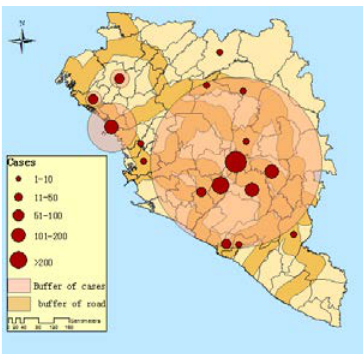
Figure 5. Impact of traffic routes on epidemic cases through buffer